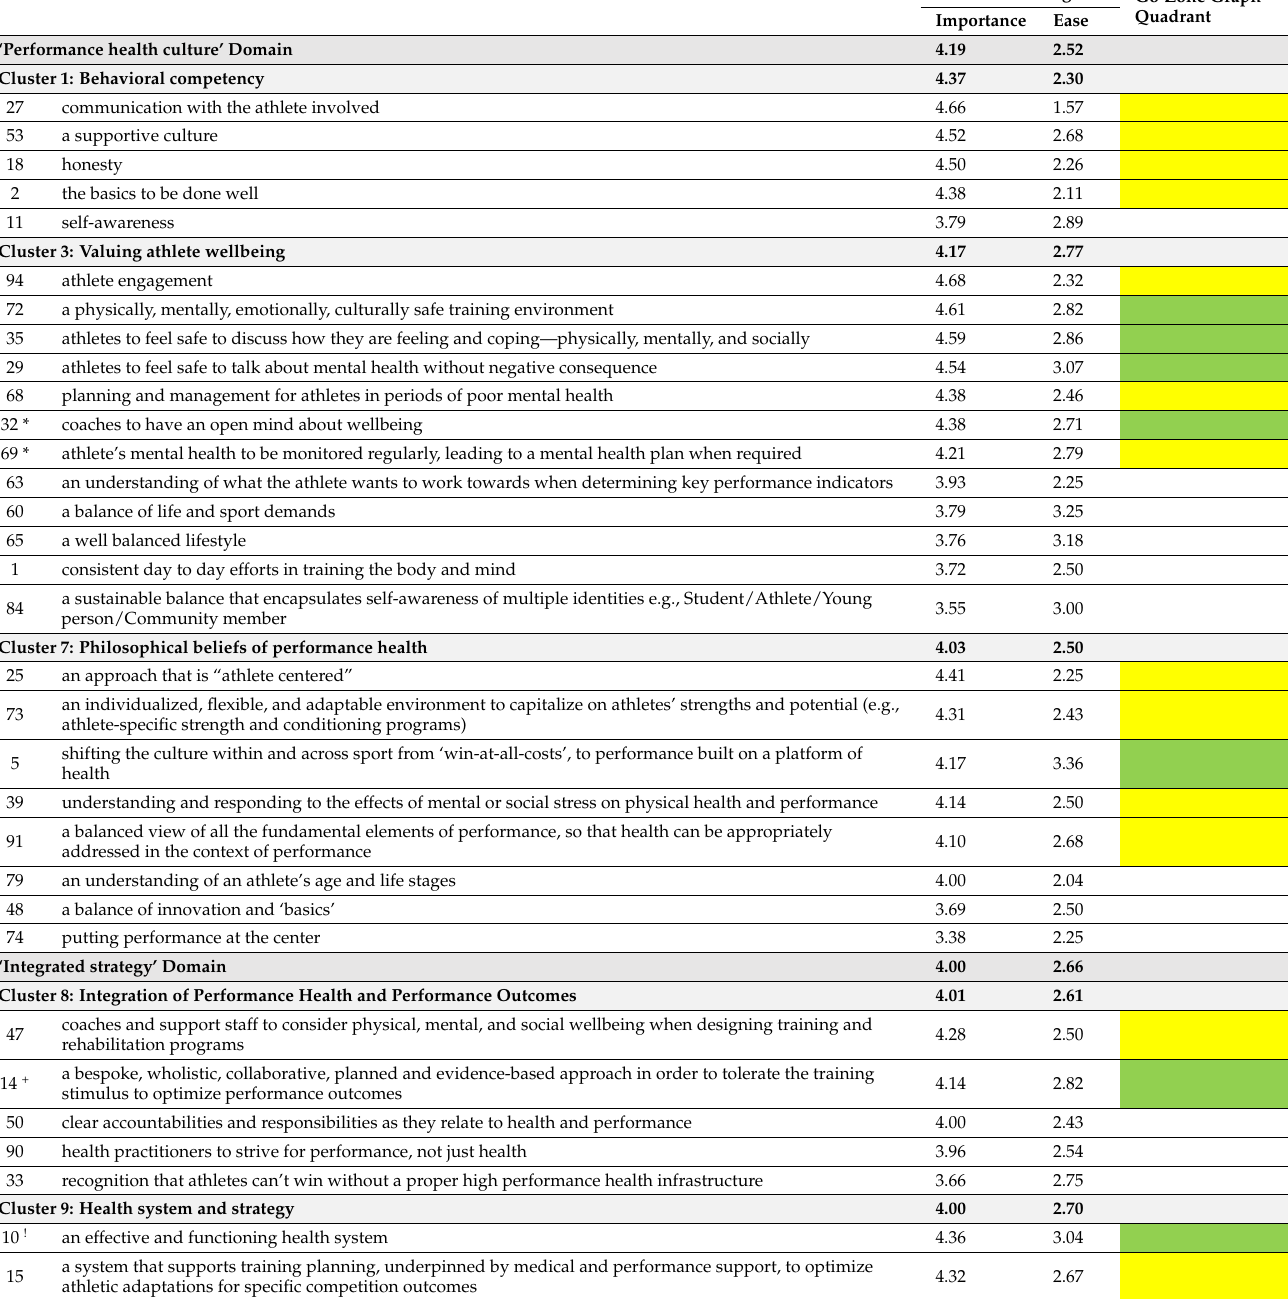
Table 2. Statements generated during the concept-mapping brainstorming process including the domain and cluster in which each statement fits, mean importance and ease of overcoming ratings, and go-zone graph quadrants for each statement. Importance: 1 = Not at all important, 5 = Extremely important. Ease: 1 = Easiest to achieve, 5 = Hardest to achieve. Top right quadrant: above mean importance that are the hardest to achieve (green). Bottom right quadrant: above mean importance that are easiest to achieve